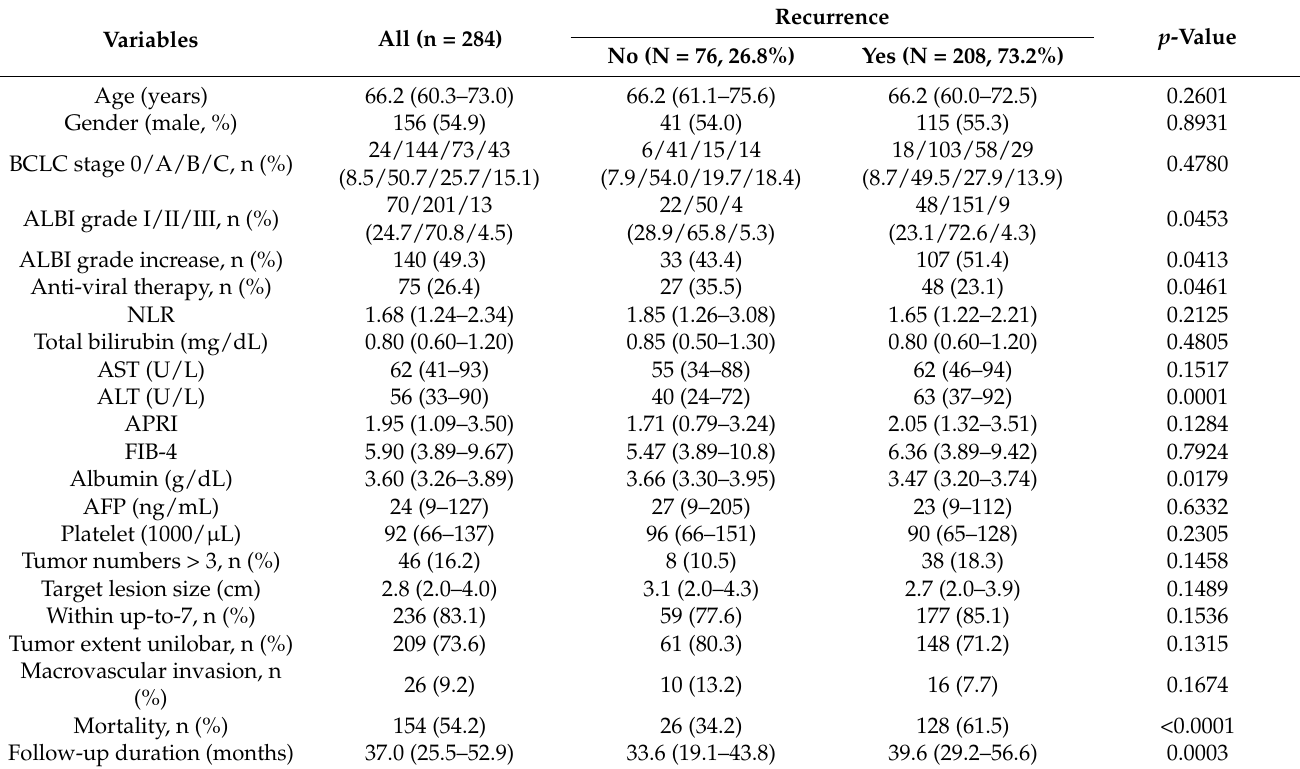
Table 3. Baseline clinical characteristics of patients with overall recurrence vs. non-recurrence.